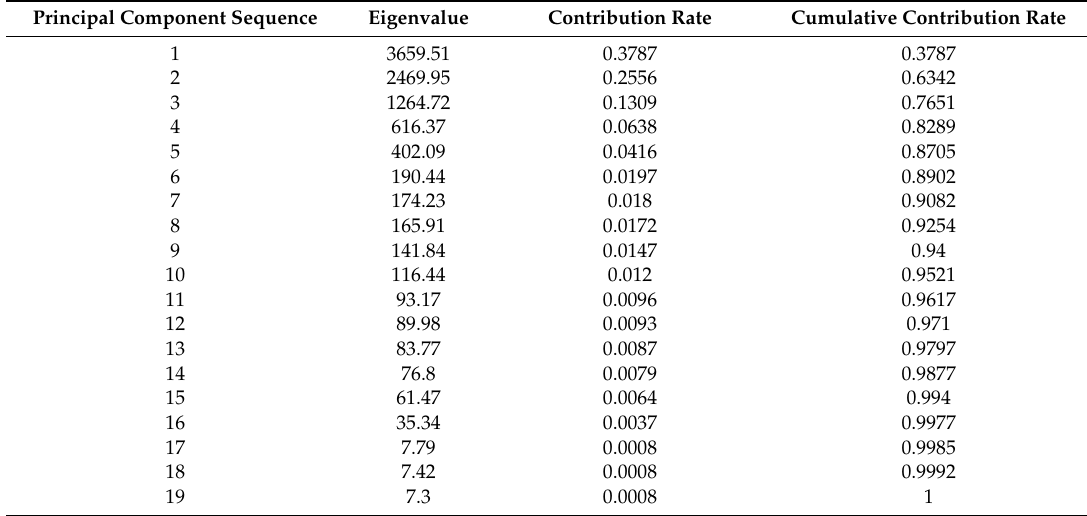
Table 2. Eigenvalues and contribution